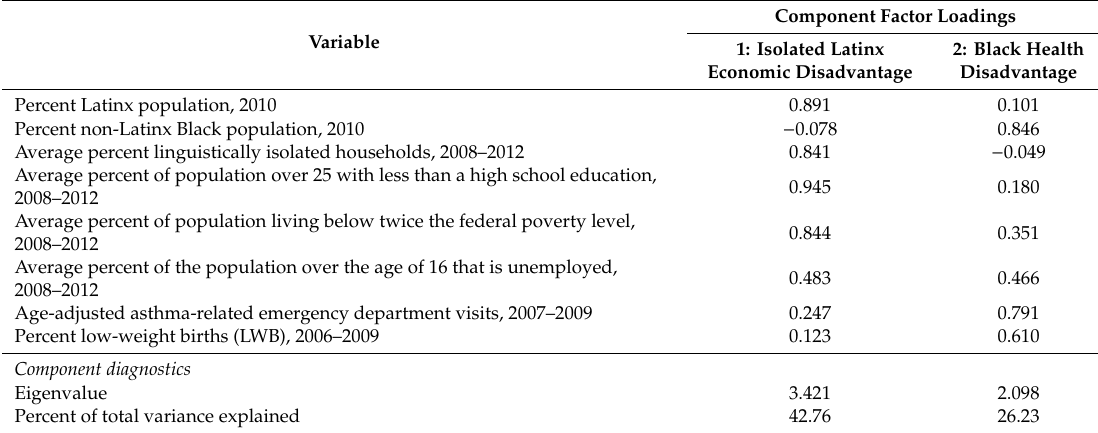
Table 1. Principal component analysis results for race-based concentrated disadvantage ( N = 7610 tracts) 1 .